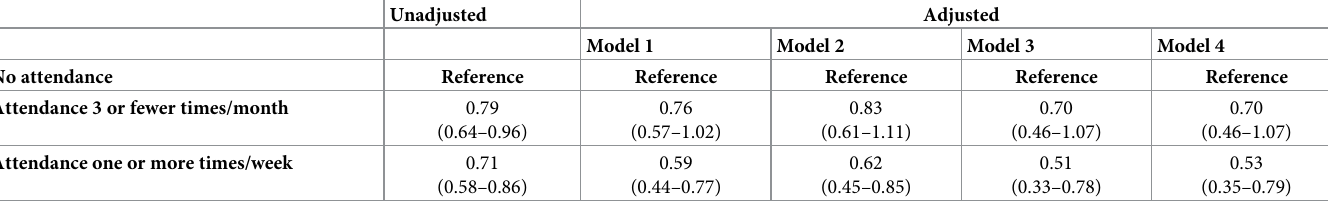
Table 2. Hazard ratios for all-cause mortality by religious service attendance for Black Men 50 and older in NHANES